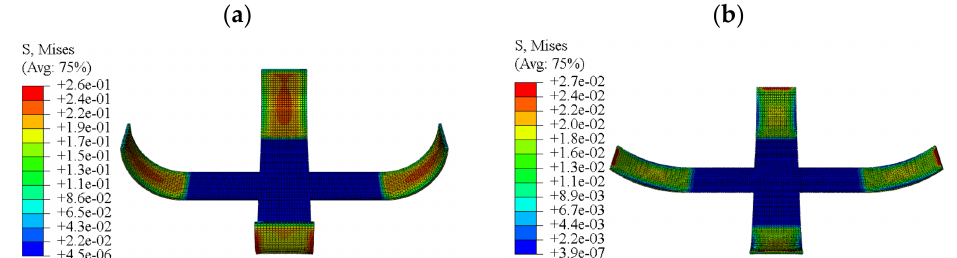
Figure 24. Response stress diagram for the F-DS: ( a ) stress cloud map of the F-DS subjected to external loads; ( b ) high-temperature recovery stress cloud map of the F-DS.